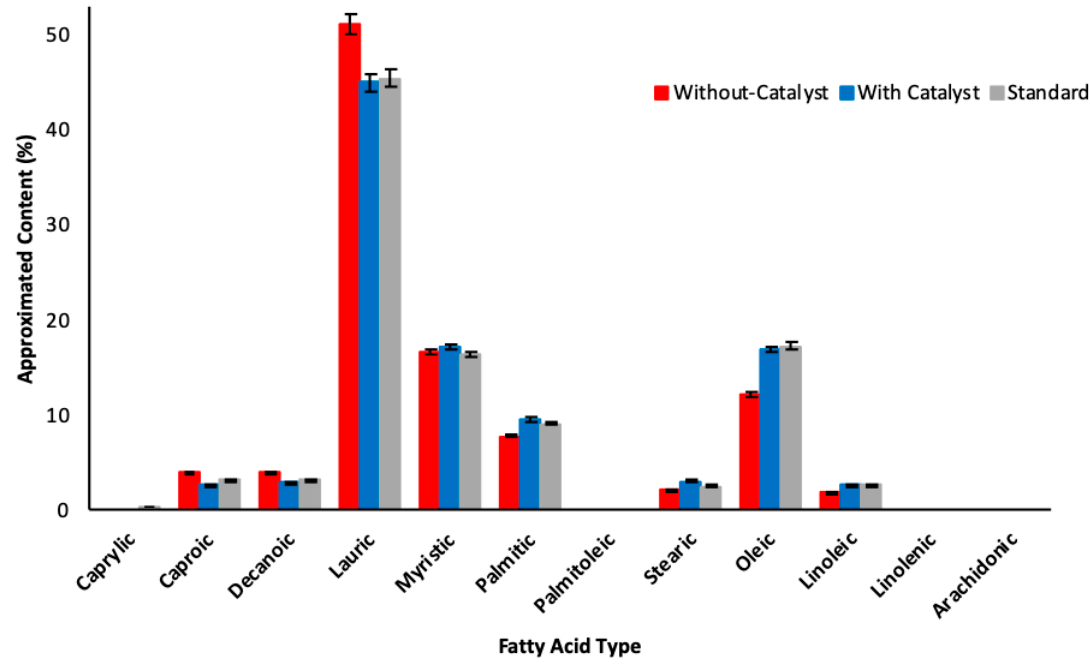
Figure 3. Fatty acid profiles for samples without catalyst, with catalyst and standard (Error bars represent 1.96%).